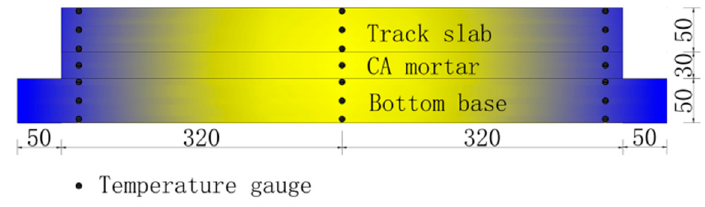
Figure 3. The layout of the temperature gauges (Unit: mm).